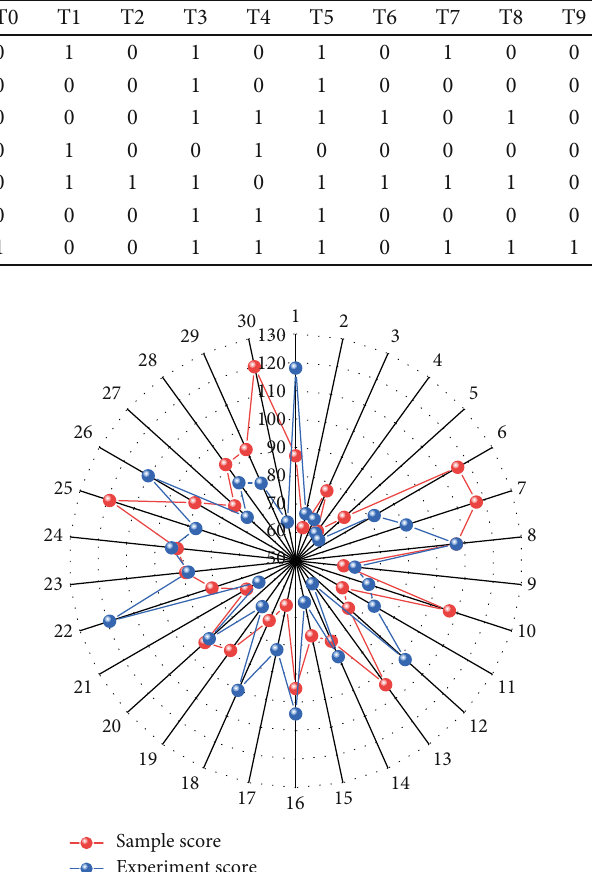
Figure 7: Comparison of sample and experimental attendance